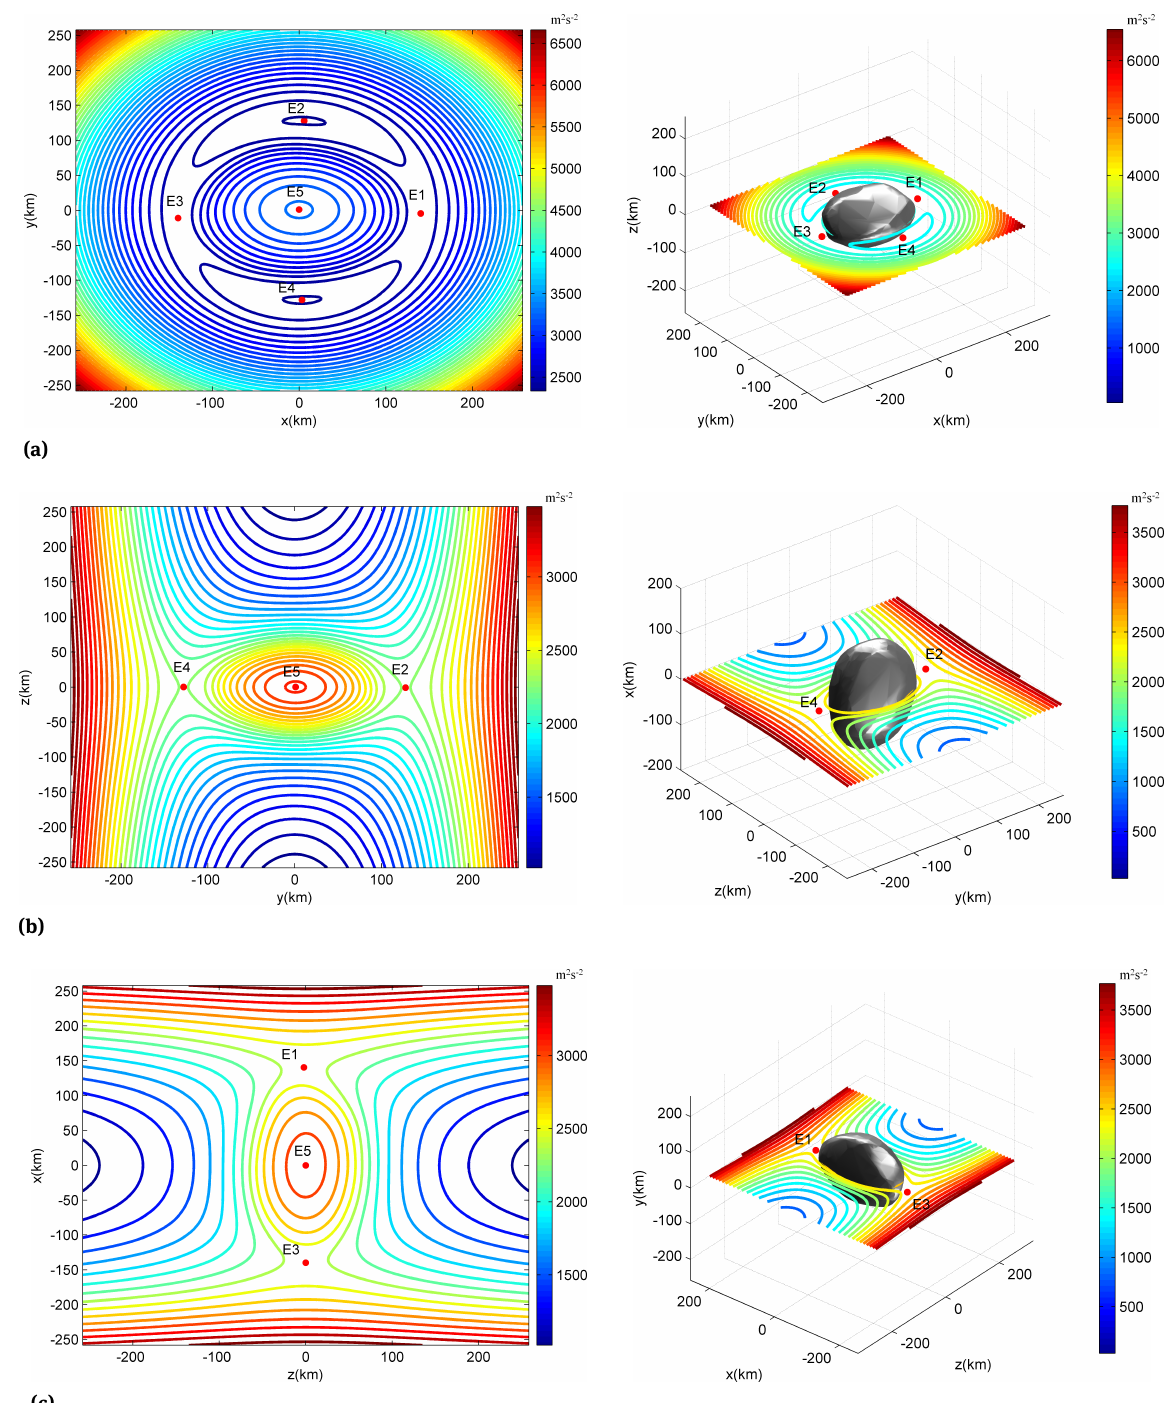
Figure 4. Zero-velocity curves and equilibrium points around asteroid 45 Eugenia, the unit of the values on the zero-velocity curves is m 2 s −2 . (a) Zero-velocity curves and projections of equilibrium points E1-E5 in the equatorial plane; (b) Zero-velocity curves and projections of equilibrium points E2, E4, and E5 in the yz plane; (c) Zero-velocity curves and projections of equilibrium points E1, E3, and E5 in the zx